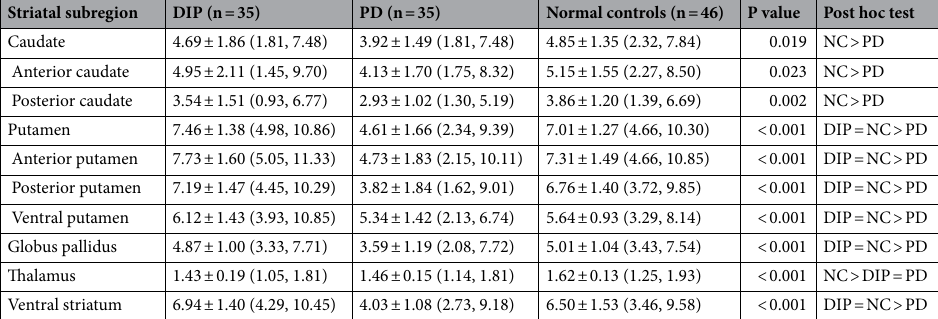
Table 3. Comparison of standardized uptake value ratios of the three groups. Values represent adjusted mean with standard deviation, and range. Analyses were using analysis of covariance with Bonferroni post-hoc testing after controlling age and sex.